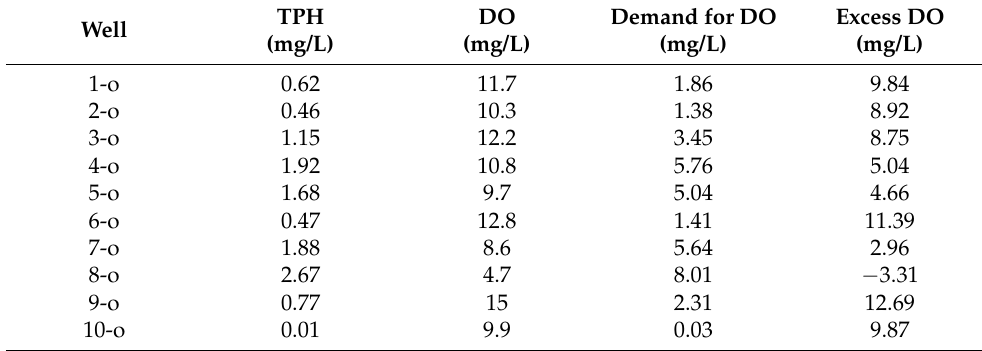
Table 2. Groundwater parameters at final stage of treatment system testing (28 August).